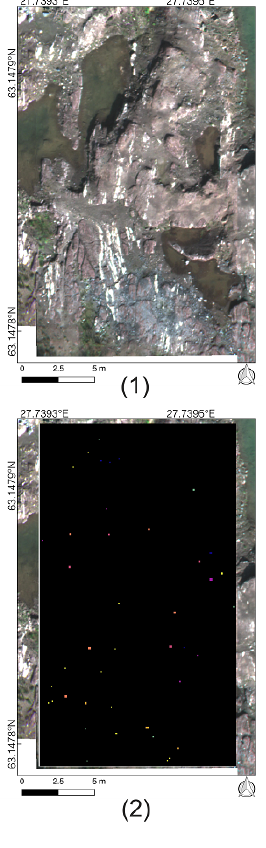
second scene of the case study area where HSIs are captured using UAV truth data for each scene are generated using the prior know- formation from acquired HSIs Figure